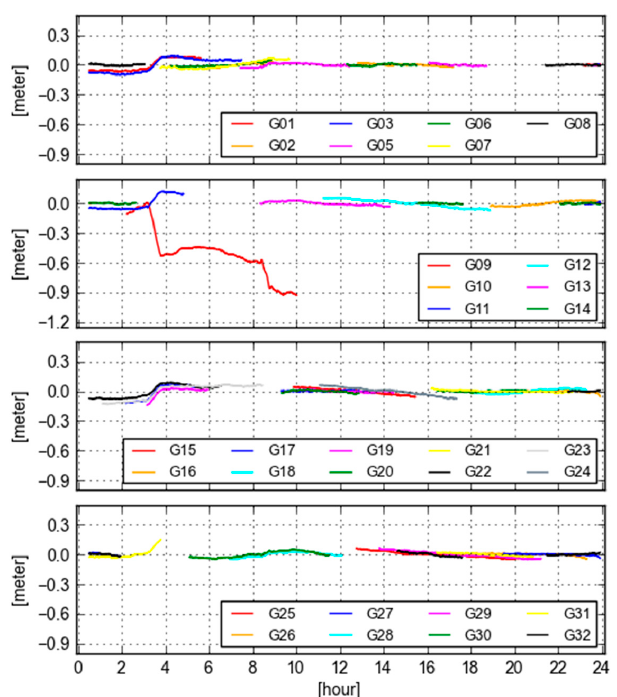
Figure 8. Variations of final orbit/clock and real-time orbit/clock differences projected into the LOS at Site KOKV for all visible GPS satellites.